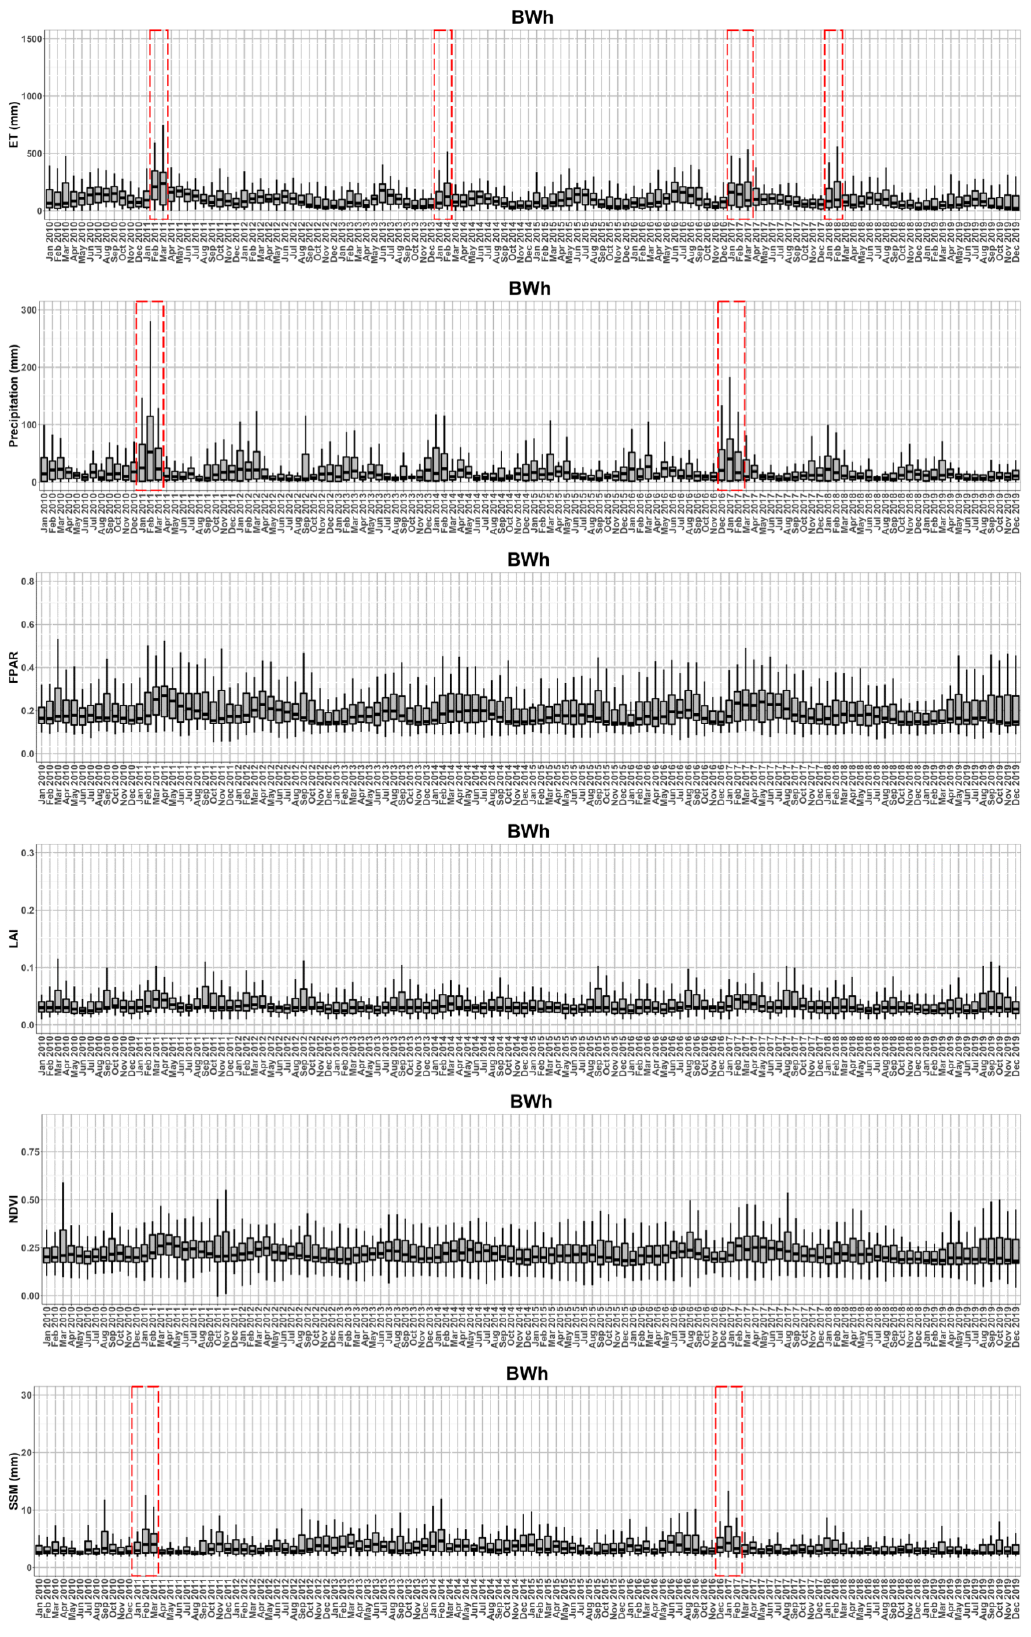
Figure 4. The time series boxplots of ET, precipitation, FPAR, LAI, NDVI and SSM between 2010 and 2019 for BWh.